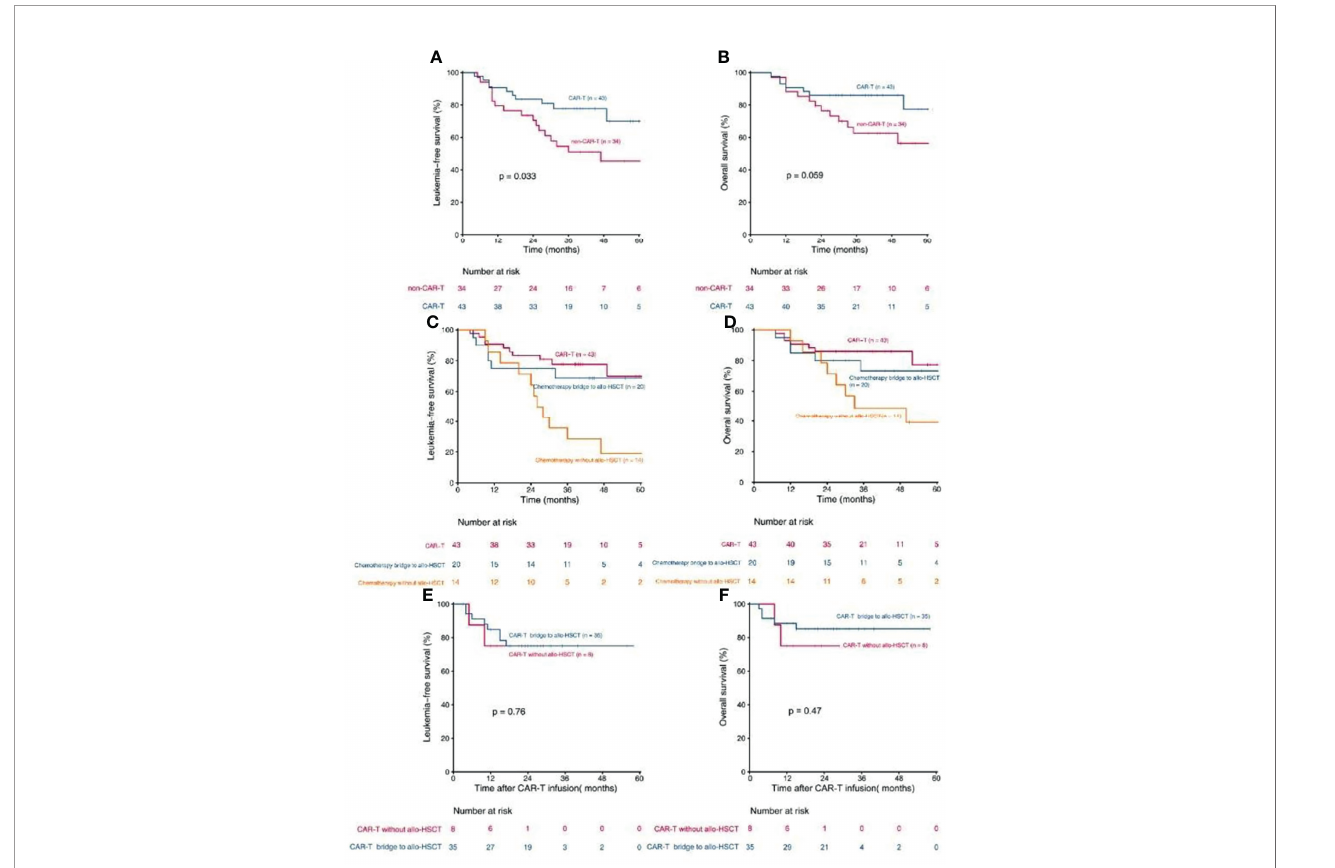
FIGURE 2 | Kaplan- Meier estimates for patients with persistent/recurrent MRD. (A) LFS rates for patients received CAR-T therapy and patients did not receive CAR-T theraphy; (B) OS rates for patients received CAR-T therapy and patients did not receive CAR-T therapy; (C) LFS rates for patients received CAR-T therapy, patients received chemotherapy bridge to allo-HSCT and patients received chemotherapy without allo-HSCT; (D) OS rates for patients received CAR-T therapy, patients received chemotherapy bridge to allo-HSCT and patients received chemotherapy without allo-HSCT; (E) LFS rates for CAR-T patients who bridge to allo- HSCT and who did not; (F) Os rates for CAR-T patients who bridge to allo-HSCT and who did